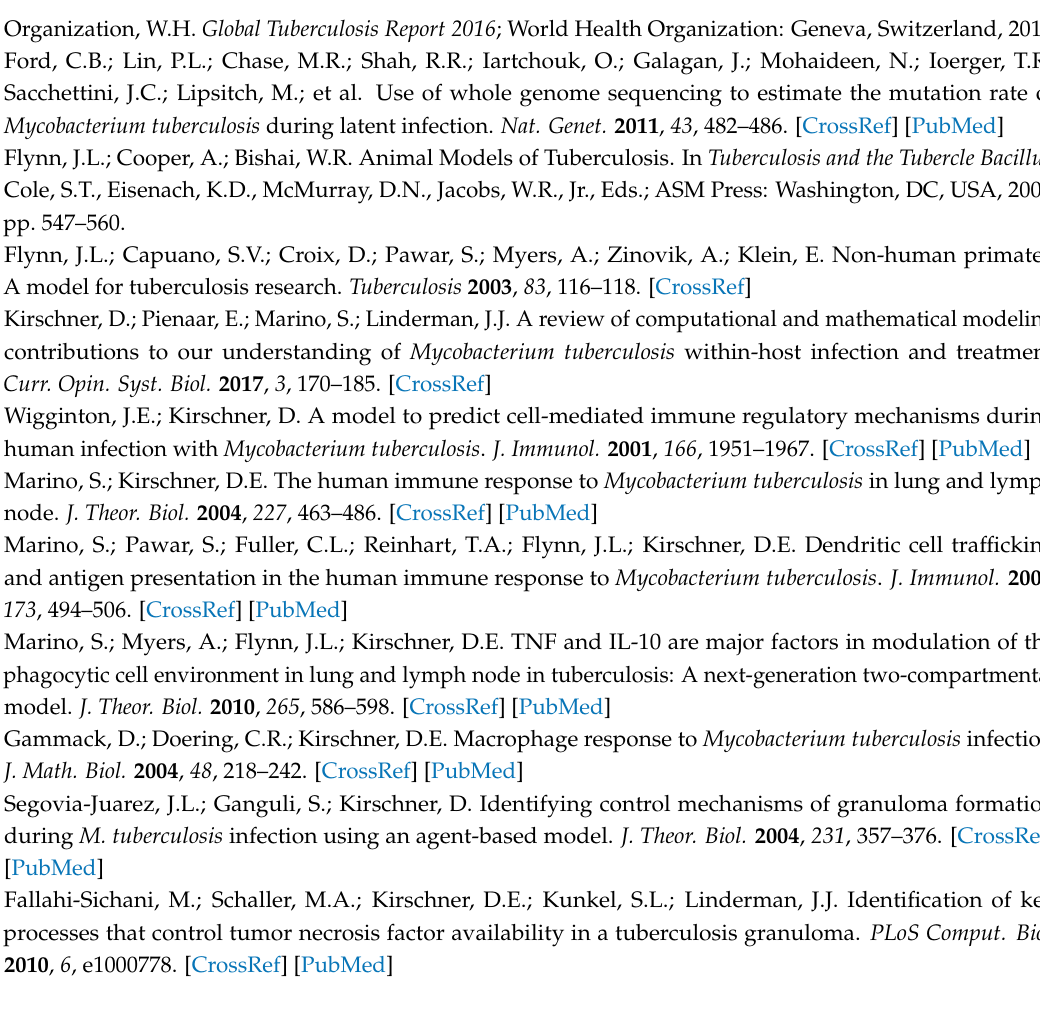
Figure S1: Examples of other in silico granulomas, visualized in 3D. Here we visualize in silico granulomas corresponding to eight of the 22 parameter files determined through the CFU calibration described in the Methods and Results section. These images illustrate some of the variation possible among the parameter files. Granulomas correspond to day 32 post infection. The list of the 90 parameters corresponding to each granuloma are shown in Table S2 in the Supplementary Material. Table S1: List of all the parameters varied in the pilot uncertainty study, with the respective description and LHS range; Table S2: list of the 90 parameters values corresponding to each granuloma shown in Figure S1. The experiment numbers shown refer to the